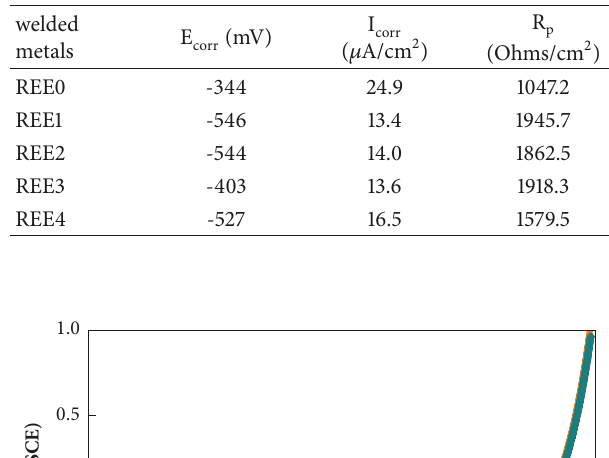
Table 10: Electrochemical data of the welded metals with different REE contents as obtained from potentiodynamic polarization mea- surements in 3.5 wt.% NaCl solution.